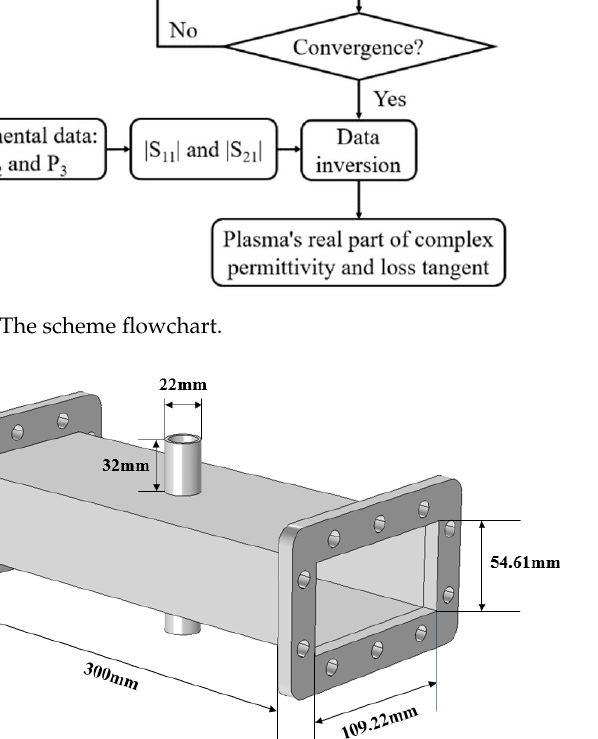
Figure 2. The scheme flowchart.